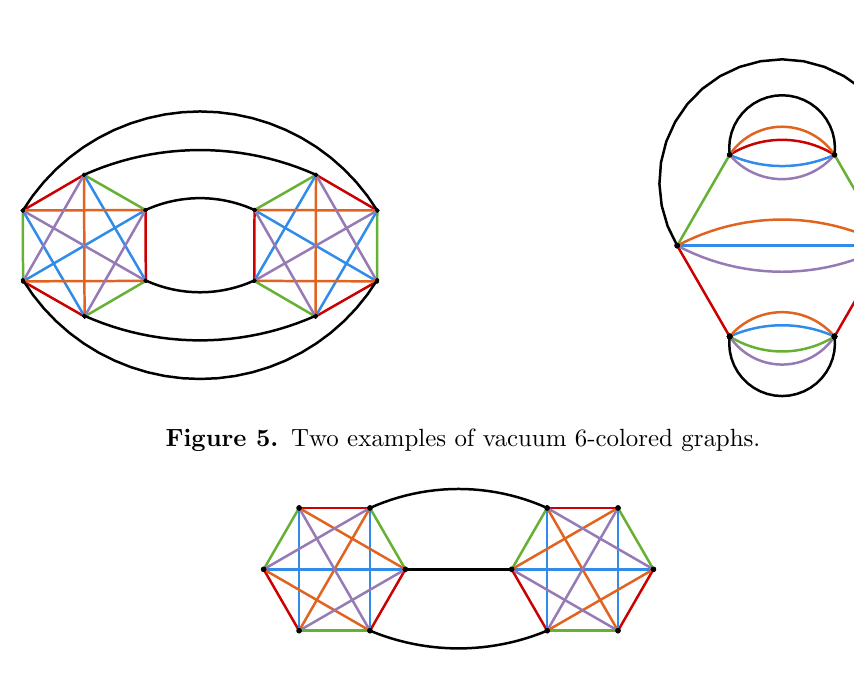
Figure 6. 6-colored graph corresponding to a two-loop correction to the six-point function, with external tensor contractions equivalent to J 6 (the